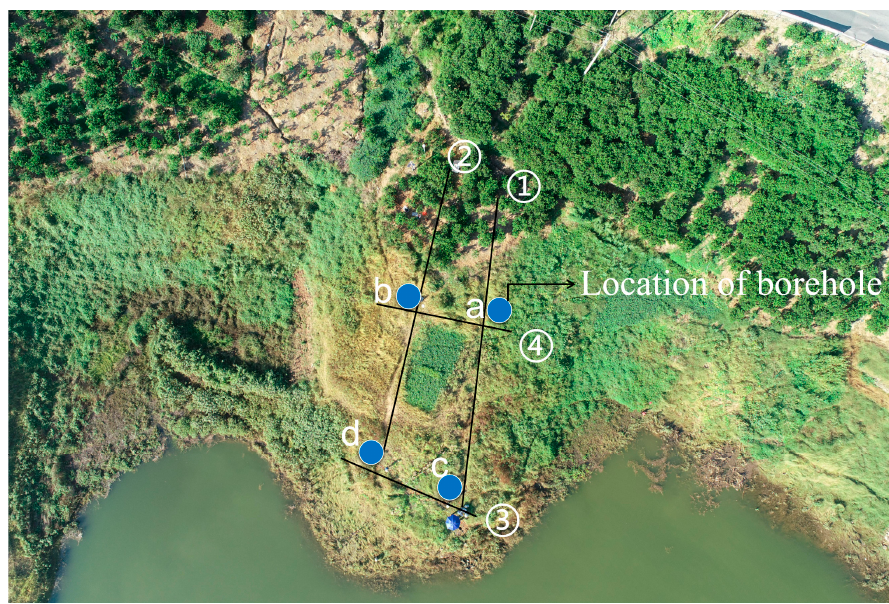
Figure 14. Layout of the high-density electrical survey line of the Baijiabao landslide.